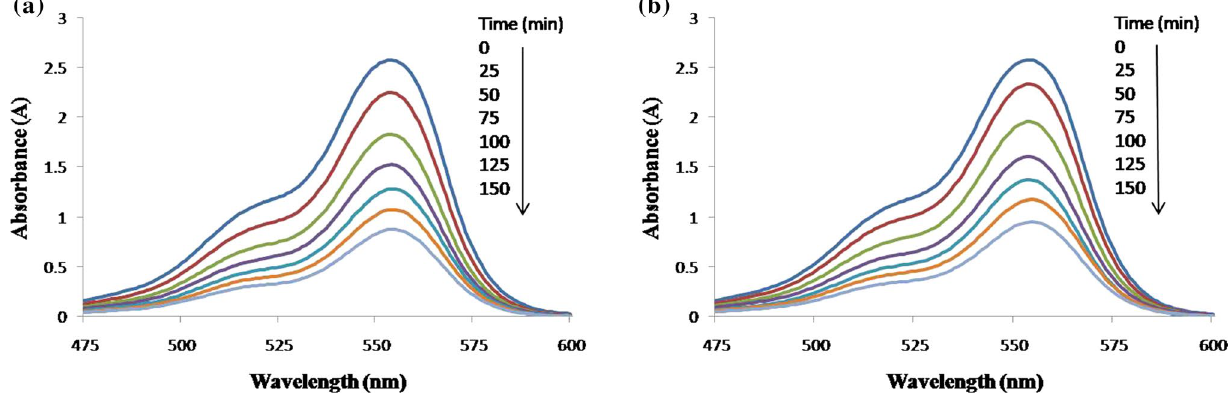
Fig. 7 UV–Vis spectra of RB dye under UV light irradiation in the presence of recovered a A-MWCNTs/Co–Ti oxide NPs and b Co–Ti oxide